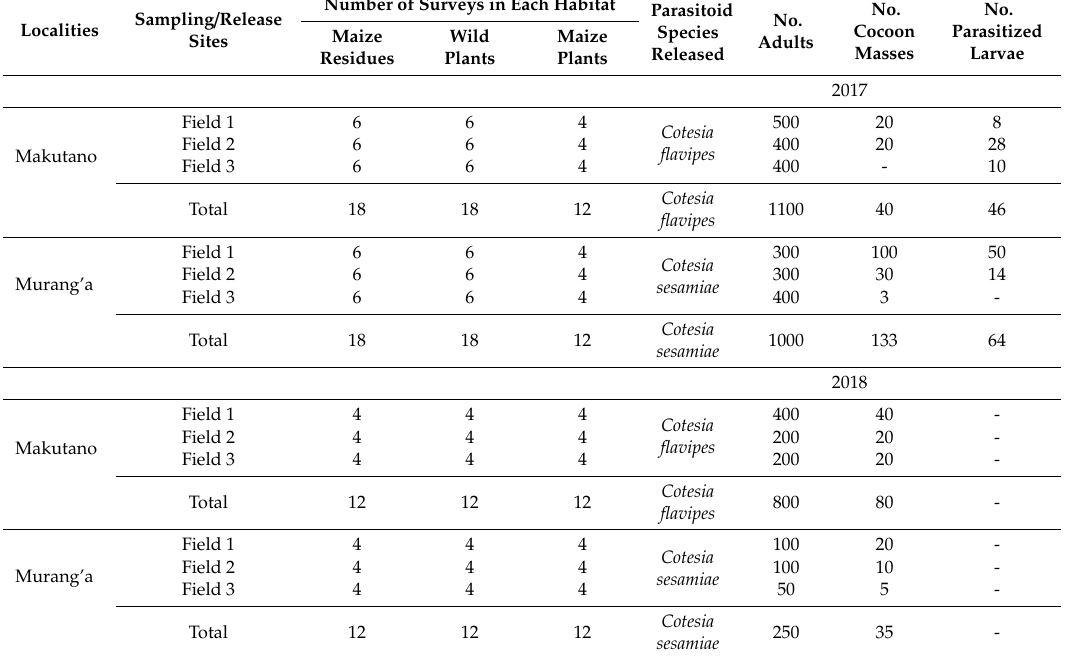
Table1. The numberof surveysin each habitatand releasesof parasitoidin maize fieldsat Makutanoand Murang’a. The parasitoid releases were done by releasing adults, cocoon masses, or parasitized larvae.